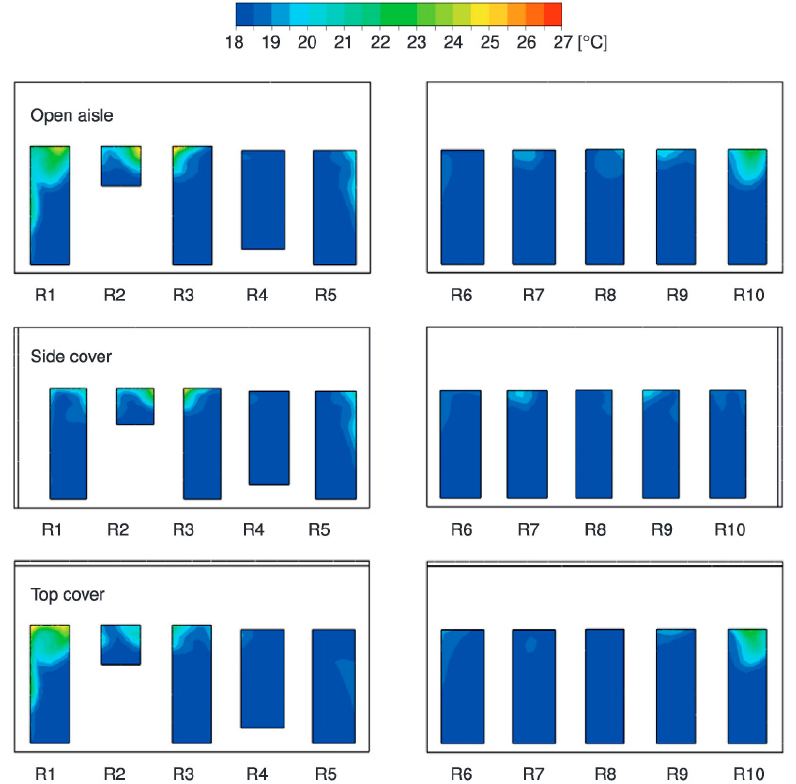
Figure 11. Rack intake temperatures for the raised floor configurations with 50% supply flow rate.